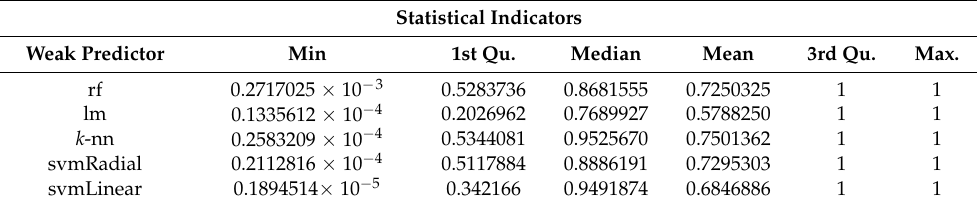
Table 3. The main statistical indicators of the results of weak predictors.